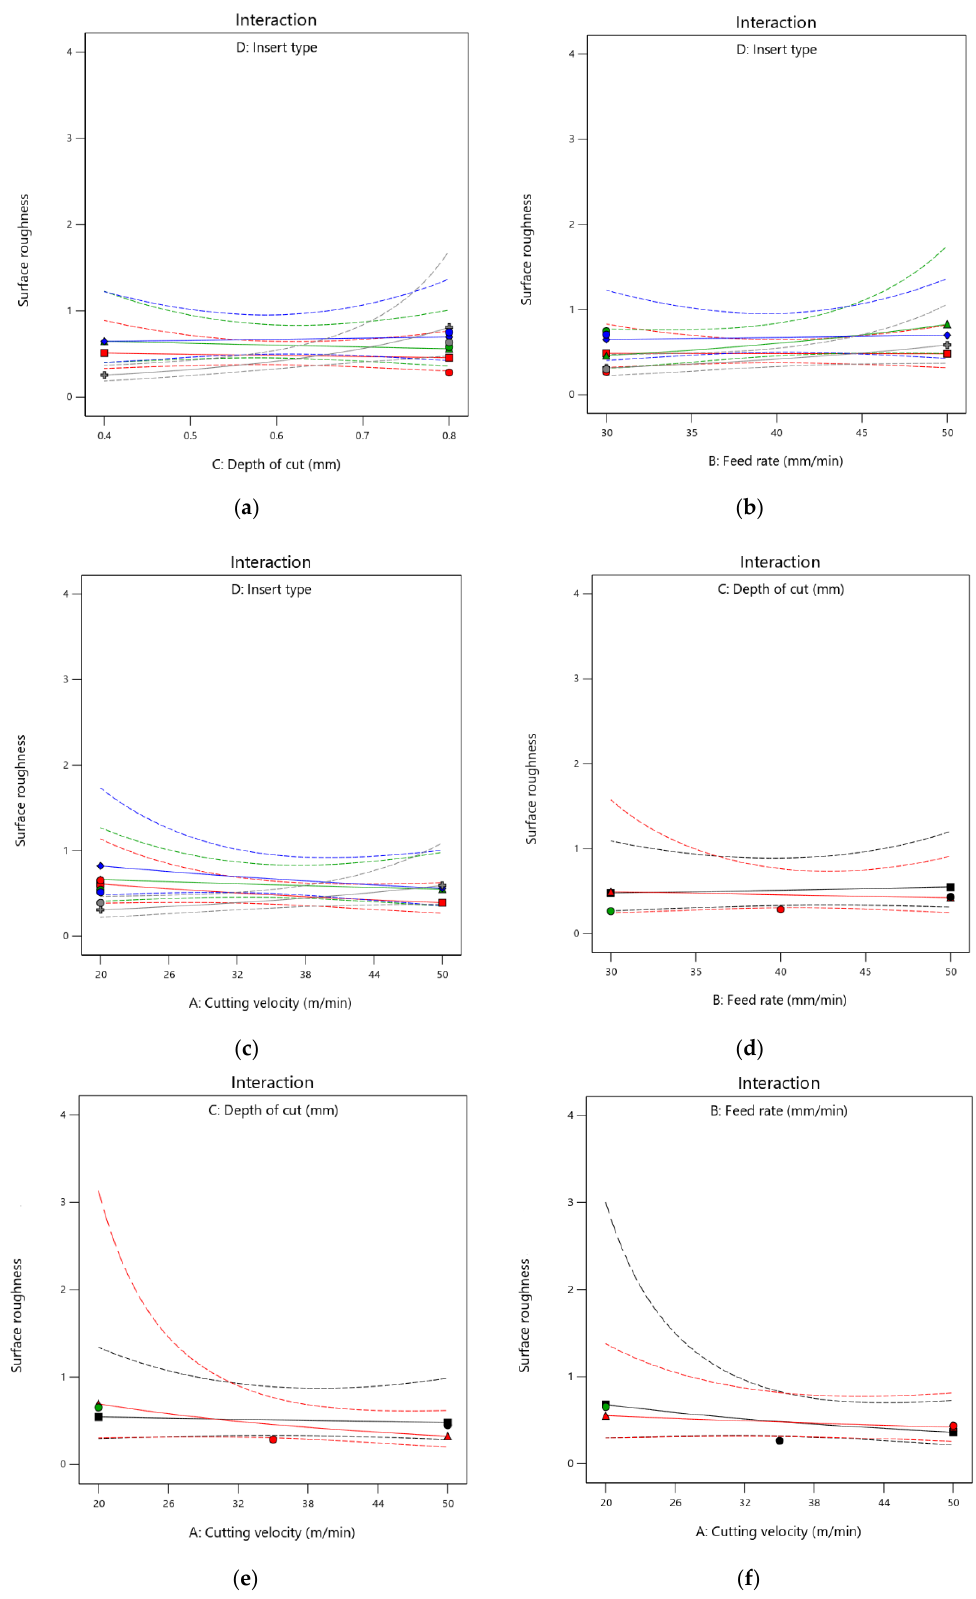
Figure 5. ( a – f ) Interaction plots for cutting velocity (A), cutting feed (B), depth of cut (C), and insert type (D) (two-factor